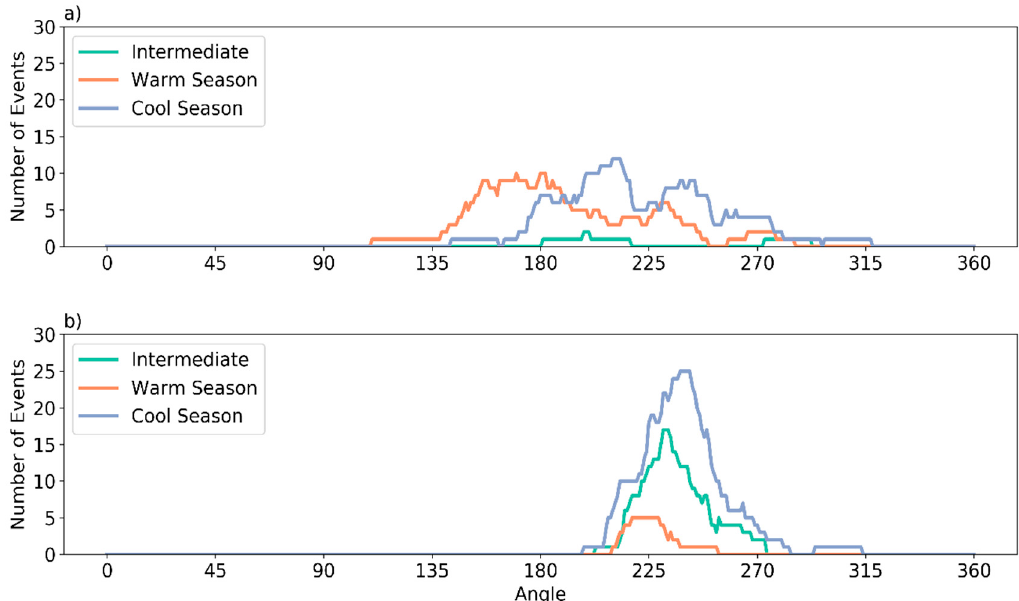
Figure 10. The relative frequency of the largest 96-h precipitation events (top 5 per year, 80 total) in the western Himalaya ( a ) and Karakoram ( b ) using bin width of 20 degrees along the x -axis. This is similar to the shaded areas in Figure 7, but here storms are separated into cool season (December–March), warm season (June–September), and intermediate seasons (April, May, October,